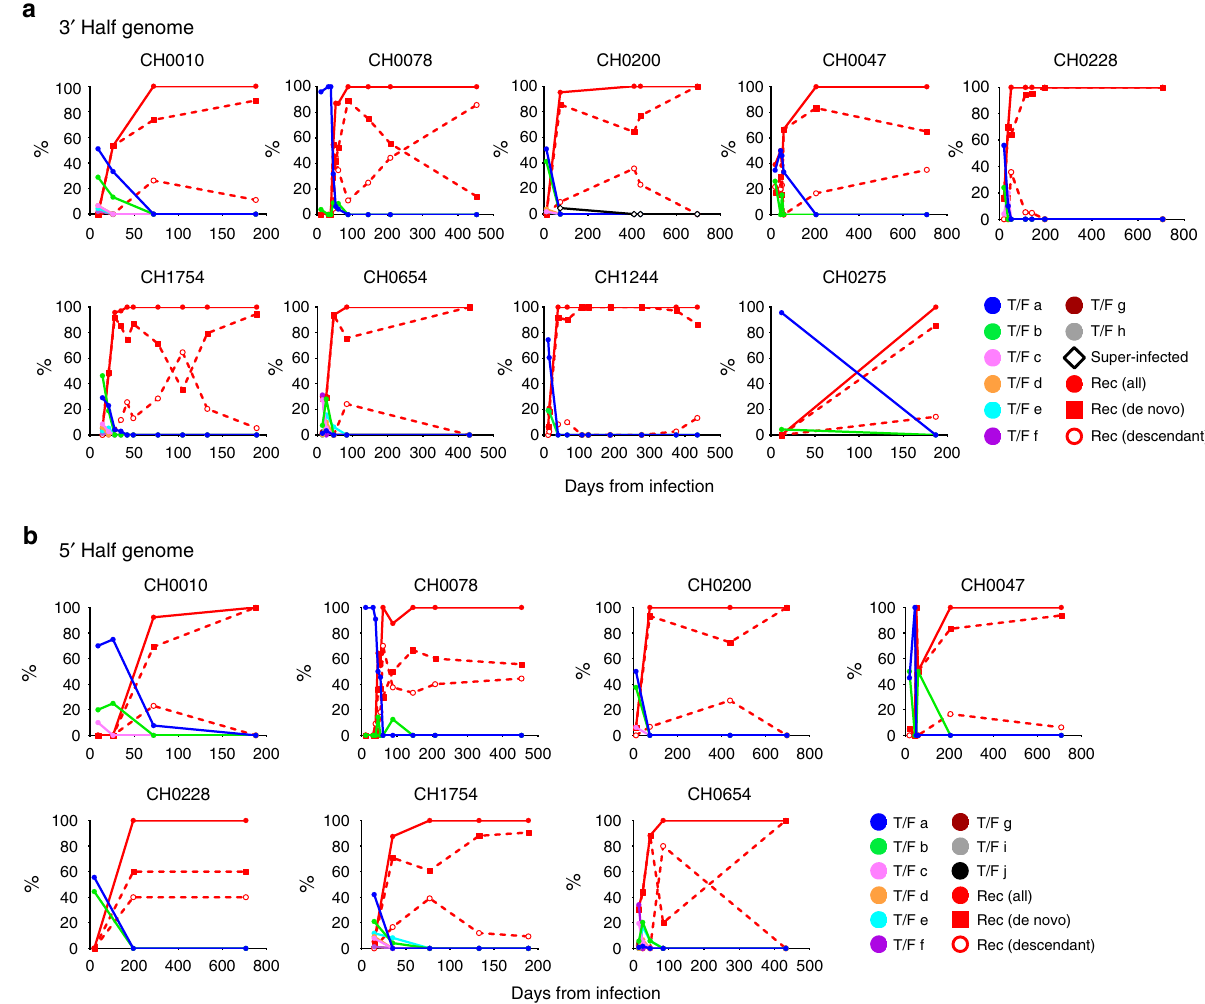
Fig. 3 Proportion of recombinants and their descendants in the viral population over time. The 3 ′ half genome ( a ) and 5 ′ half genome ( b ) sequences were analyzed separately. At each time point, colored dots indicate the percentages of T/F sequences and their lineages, red dots indicate all recombinants, red squares de novo recombinants, red circles descendants of recombinants, and open diamonds superinfection